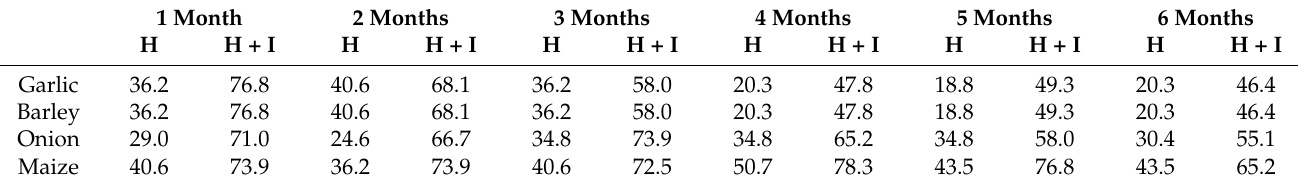
Table 8. Level of accuracy between the type of growing period estimated with the months before sowing, and the type of growing period from sowing to harvest